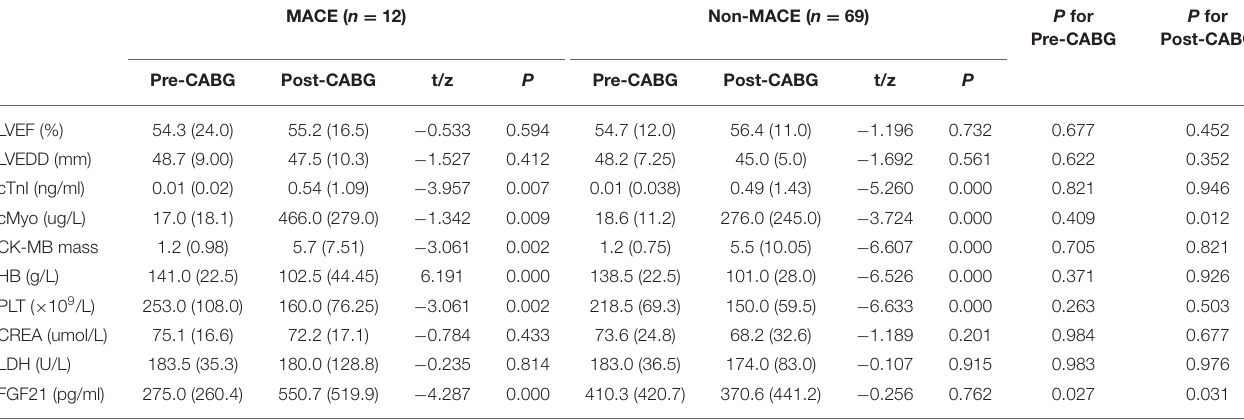
TABLE 2 | The risk parameters related to myocardial infarction in 81 MI patients with or without MACE who had undergone CABG. MACE ( n = 12) Non-MACE ( n = 69) P for